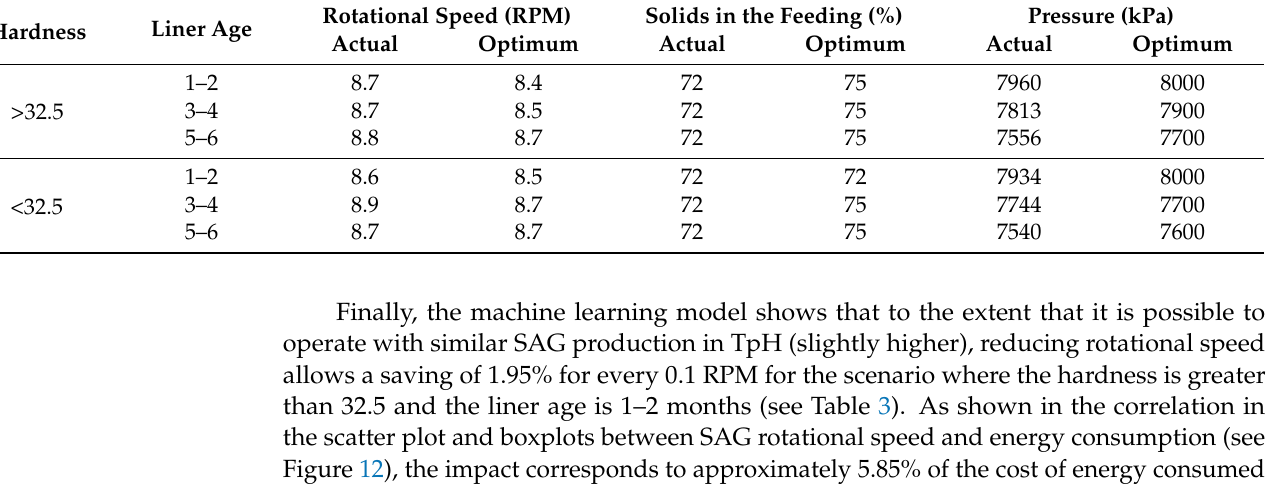
Figure 11. Optimum configuration of the percentage of solids and pressure in the SAG mill. The usual state of operation (a) and optimum state of operation (b). Table 3. Optimal operating guidelines for the SAG